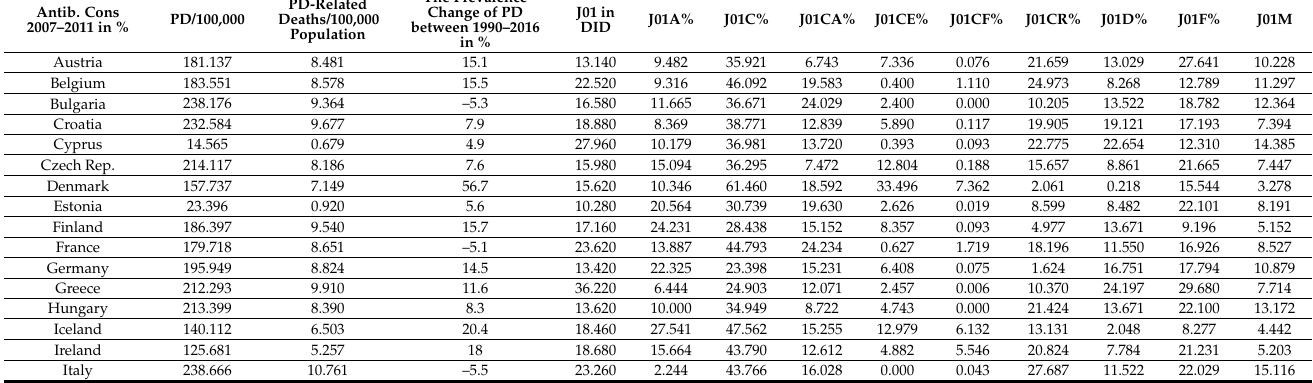
Table 3. Average antibiotic consumption for 2007–2011 expressed as a relative share in % of the total systemic antibiotic consumption in the community estimated in Defined Daily Dose/1000 Inhabitants/Day (DID) compared to the prevalence of PD estimated for 2016, the change of prevalence between 1990–2016 in percentage (%), and the PD-related deaths/100,000 population. Positive, significant correlation or significantly elevated risk was estimated, when the p -value showed ≤ 0.05 ( p = ≤ 0.05) (marked with yellow filling color) and the negative correlation or lowered risk was marked with green filling color. Positive/negative, non-significant correlations or elevated/lowered risks were considered when the p -value fell between 0.051 and 0.09 ( p = 0.051 ≤ 0.09) and marked with an orange filling